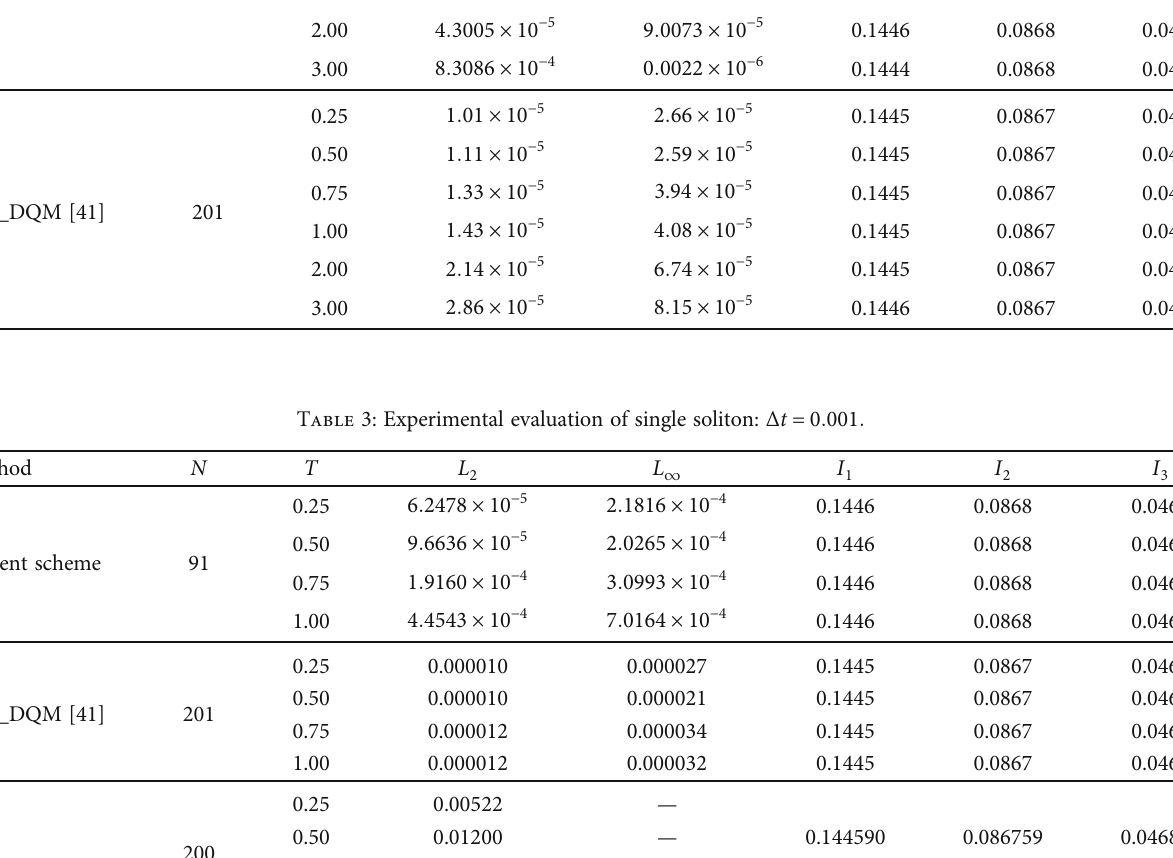
Table 1: Values of B